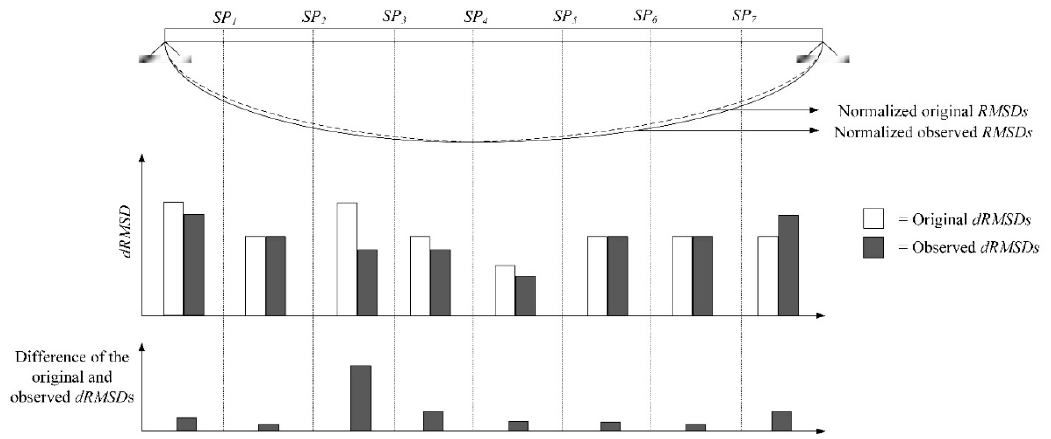
Figure 9. Illustration of Level 2 damage indicator.